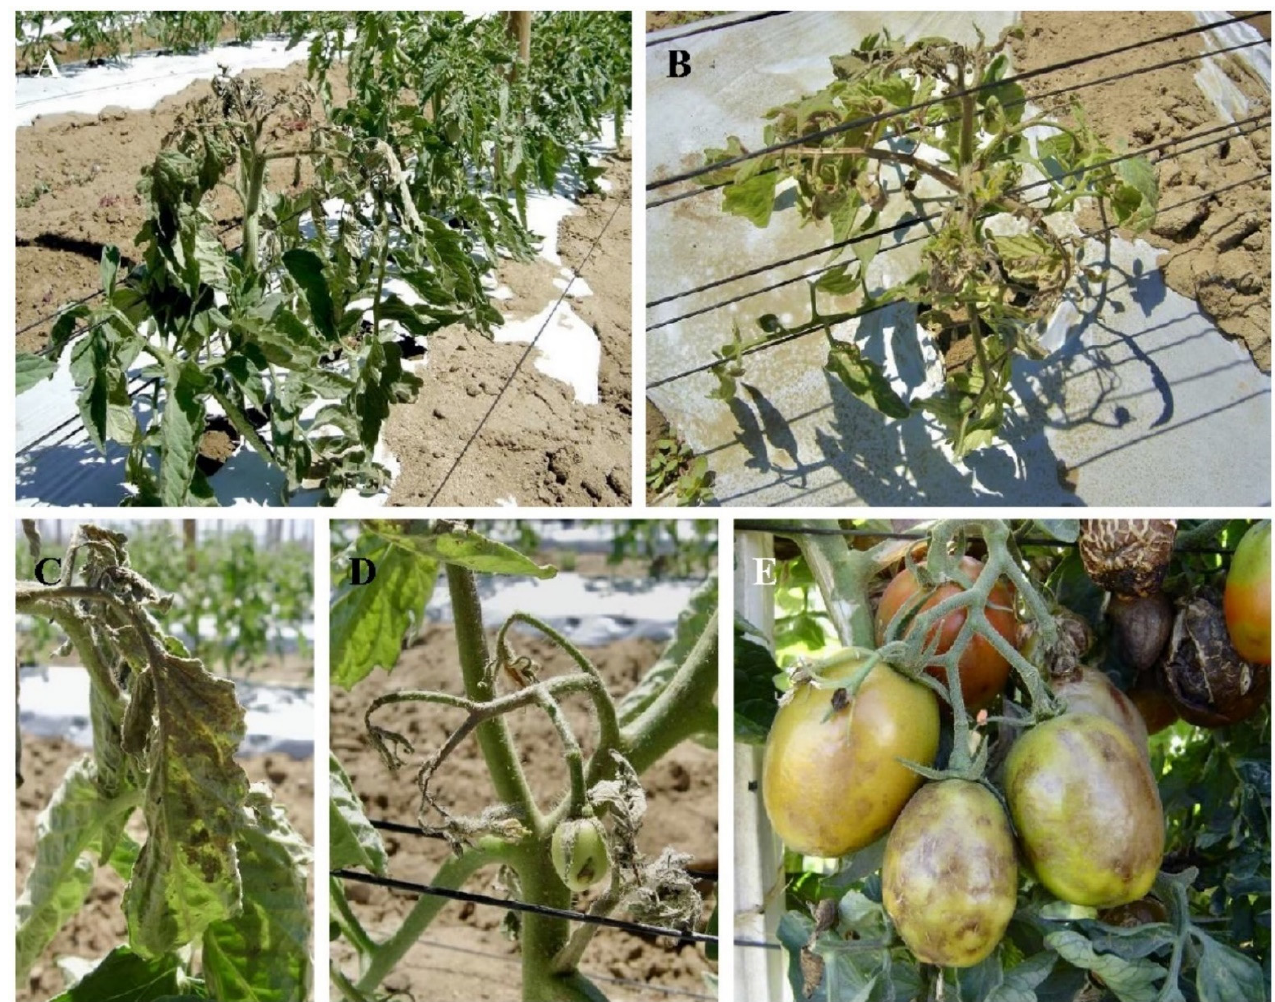
Figure 5. Symptoms caused by tomato marchitez virus on tomato plants. ( A , B ) Infected plants showing necrosis in the superior third. ( C ) Leaflet necrosis. ( D ) Flower necrosis. ( E ) Fruits with necrotic spotting.